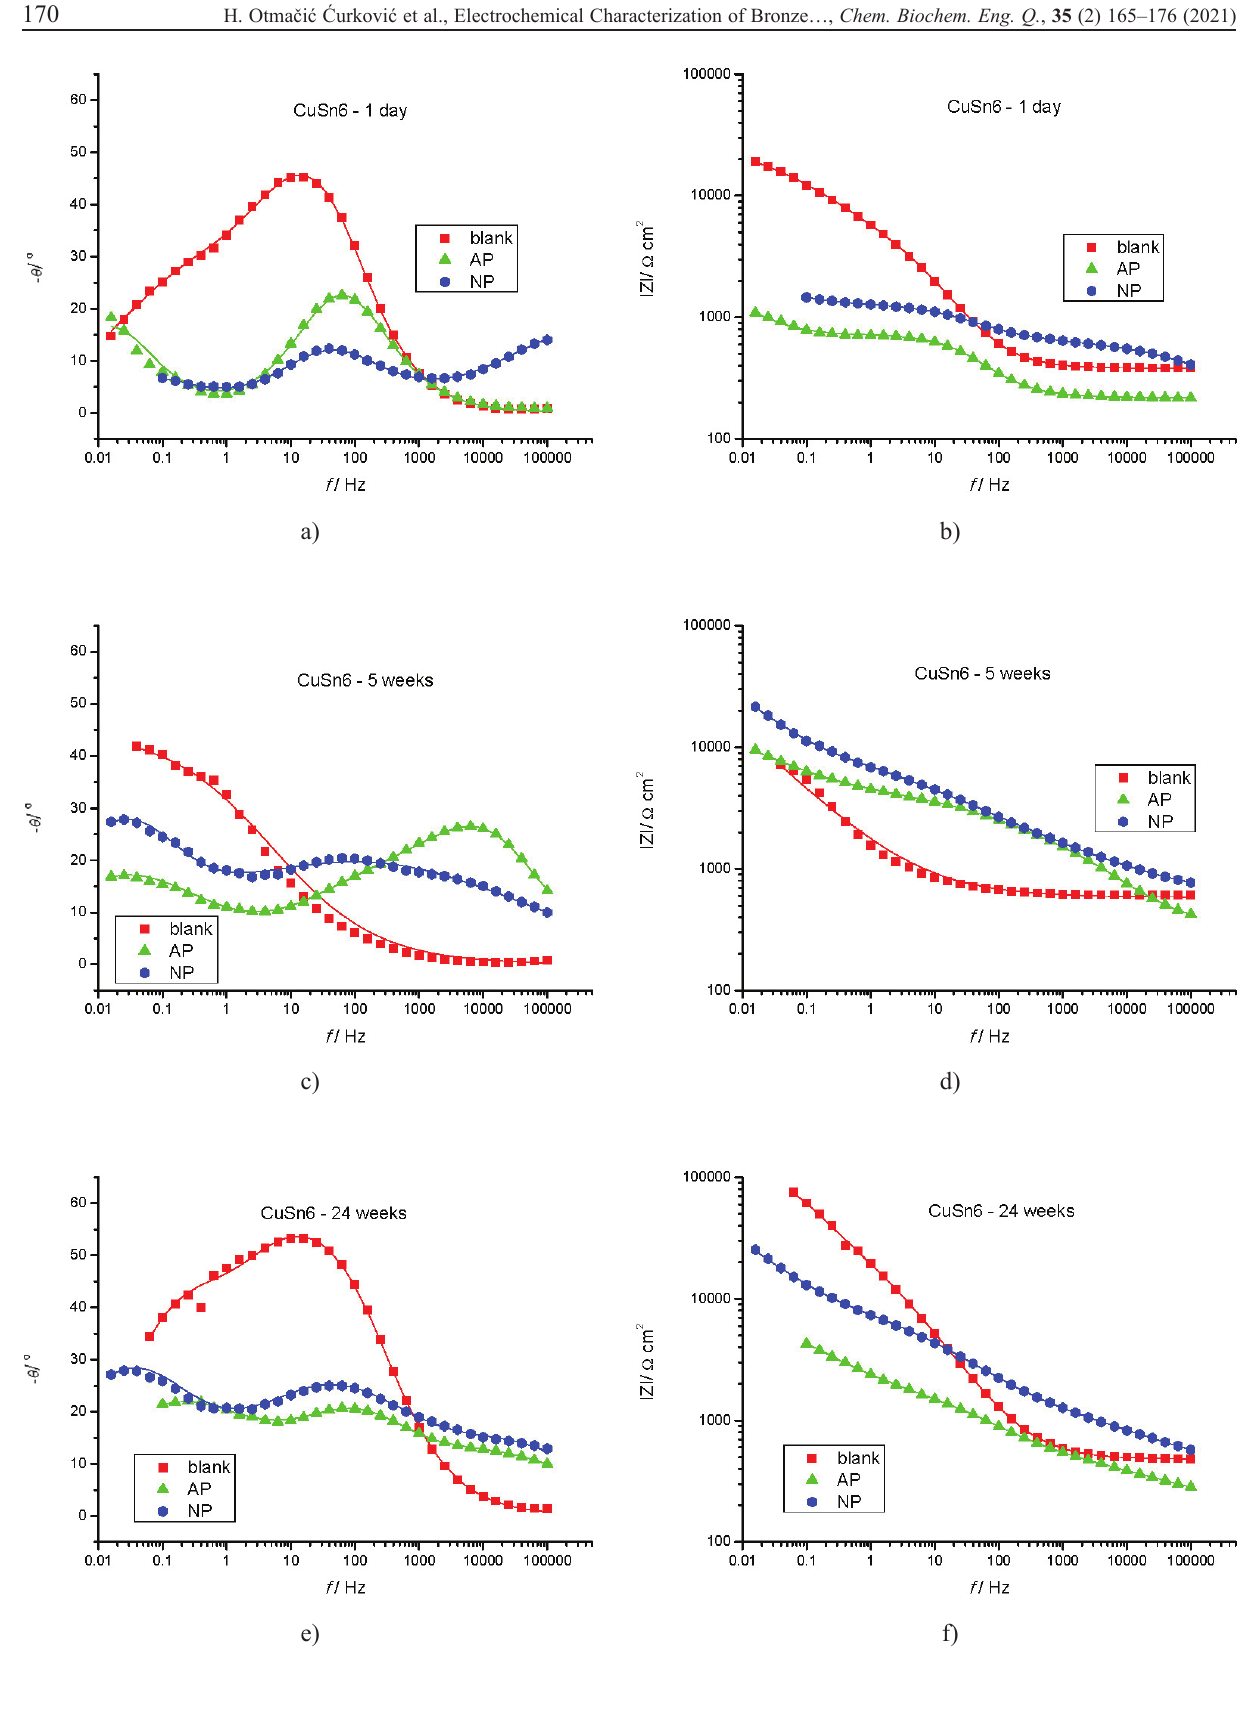
Fig. 3 – Bode impedance plots for blank and patinated CuSn6 samples collected after different periods of exposure to outdoor at-